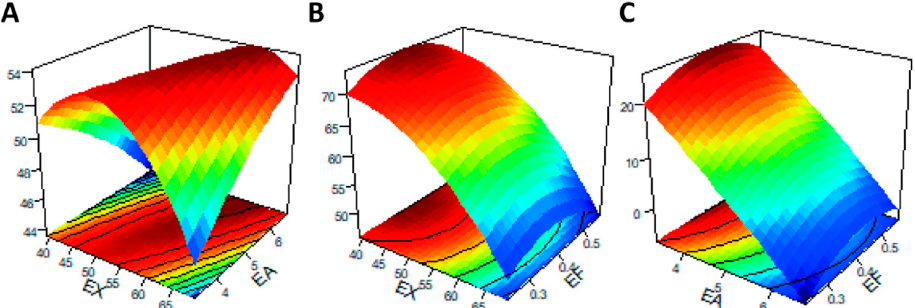
Figure 5. Response surface and contour plots of the interaction effects between enzyme addition levels for factors [( A ): EX/EA; ( B ) EX/EF; ( C ) EA/EF] on the reducing sugars (y 1 ). The abscissa axis at the bottom of the figure represents the two enzyme factors, respectively, and the vertical axis upward represents the corresponding response index (y). The associated contour plots were composed of the densely arranged circles on the underside.